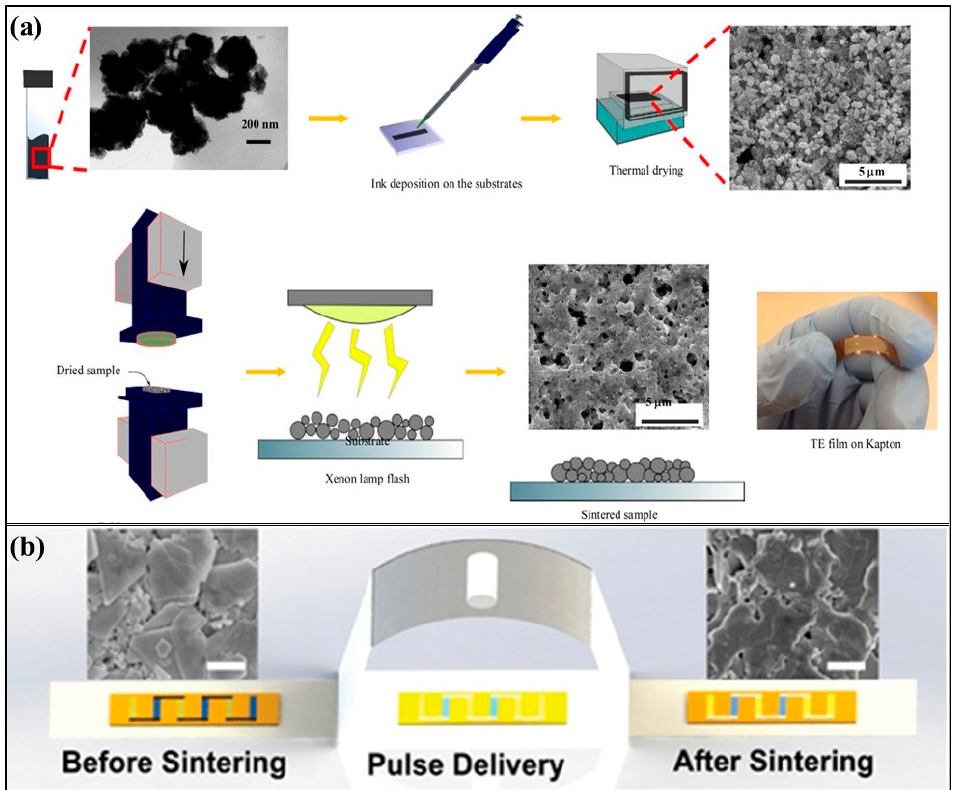
Figure 11. ( a ) Schematic illustration showing the Bismuth Telluride Thermoelectric film preparation by photonic sintering. Reproduced with permission from [104]. Copyright 2018, Advanced Engineering Materials. ( b ) Illustrating the effect of intense pulsed light sintering on Bi 2 Te 2.7 Se 0.3 nanoplates with before sintering and after sintering SEM images. Reproduced with permission from [98]. Copyright Wiley Online Library,